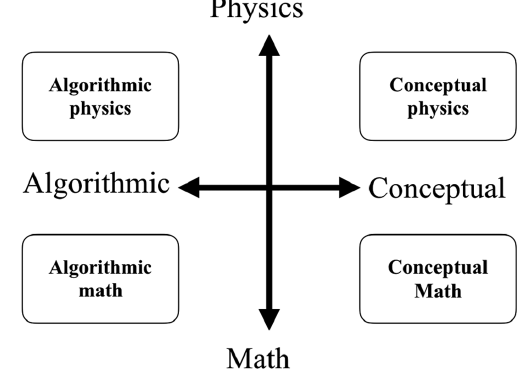
FIG. 1. Math-physics-algorithmic-conceptual theoretical framework. The horizontal axis indicates the algorithmic and conceptual directions. The vertical axis represents the math vs physics directions. Each quadrant is labeled. Figure originally from Ref.